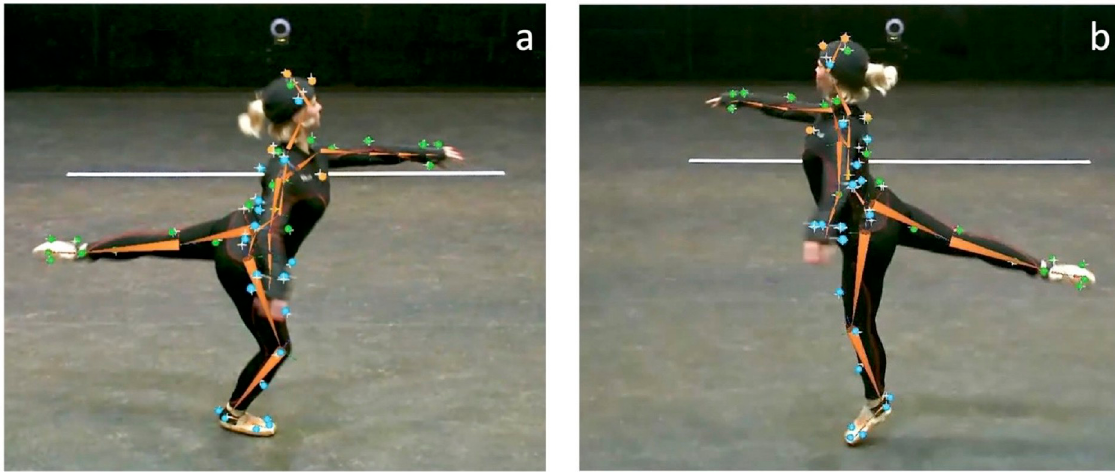
Fig 2. A still of one of the participants performing the Promenade in Arabesque figure. The participant hops on one foot, lifting the heel periodically while slowly pivoting around her axis. a) Display of the Heel Down movement onset (when the participant’s heel touches the floor). b) Display of the Heel Up movement onset (when the participant’s heel is at its maximal vertical position). Blue and green dots indicate the marker